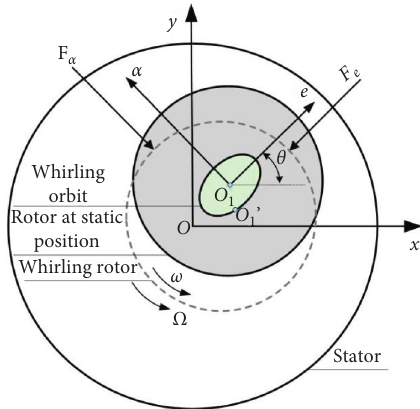
Figure 4: Rotordynamic model for annular seals.